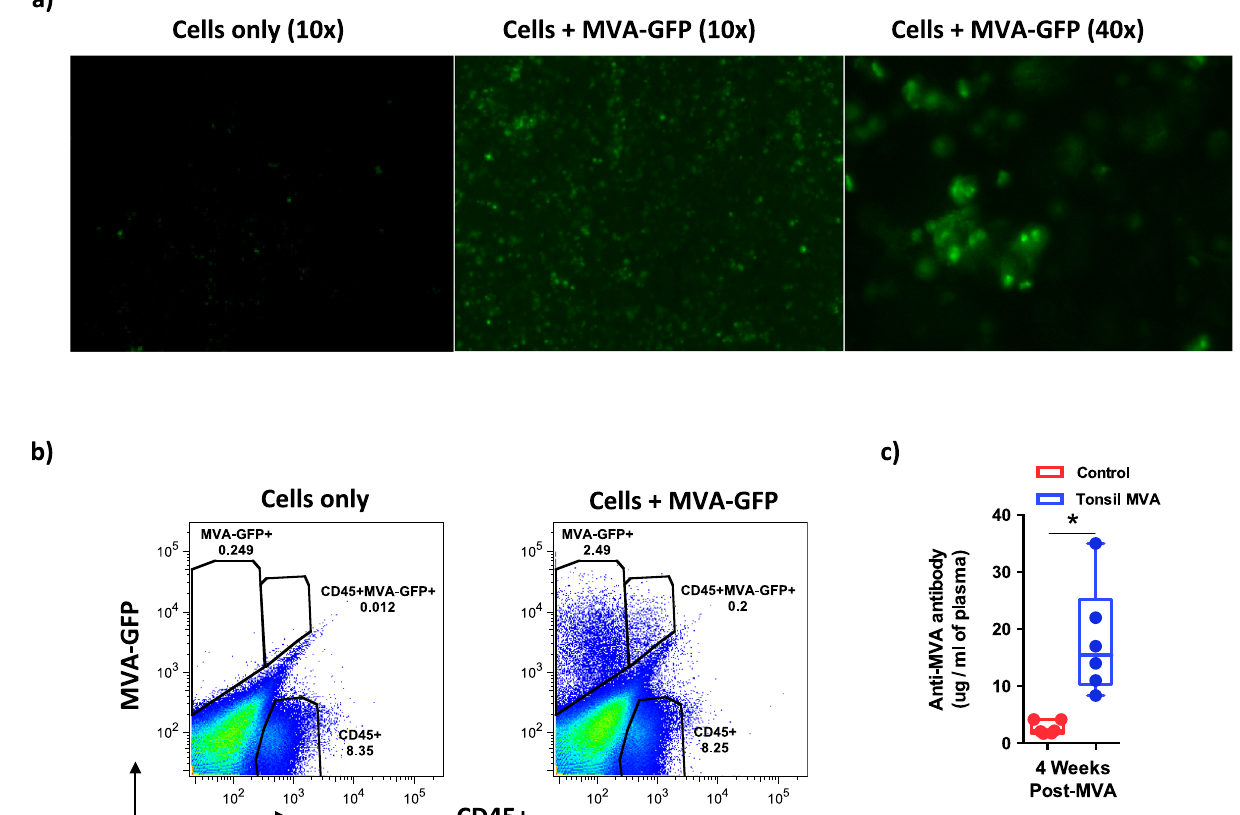
Fig. 1 | Tonsils are readily infected by MVA. Tonsil cells were co-cultured with MVA-GFPata MOI=1.0 for 24h and wereexamined by ( a ) fl uorescent microscopy and ( b ) labeled with anti-CD45 and examined fl ow cytometry. Tonsils were col- lectedfromamiscellaneousrhesusmacaqueatnecropsy.Assuch,theco-culturing experiment was only performed once. ( c ) Anti-MVA antibody levels in the plasma